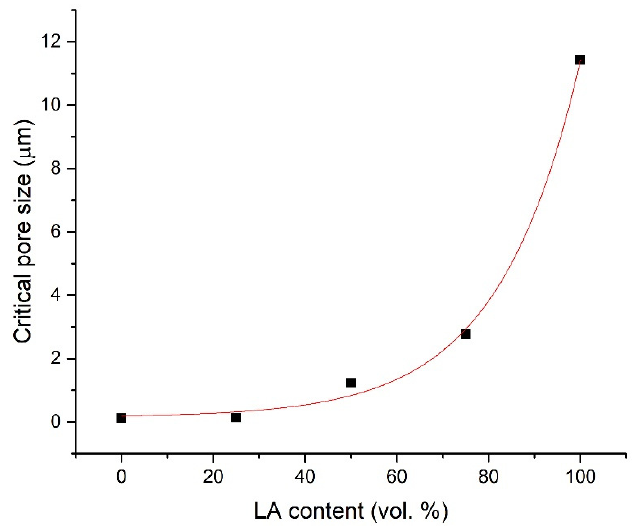
Figure 7. Pore size distribution–incremental pore volume curves measured for control (C-R) and LA dosed samples (C-LA 25–100).